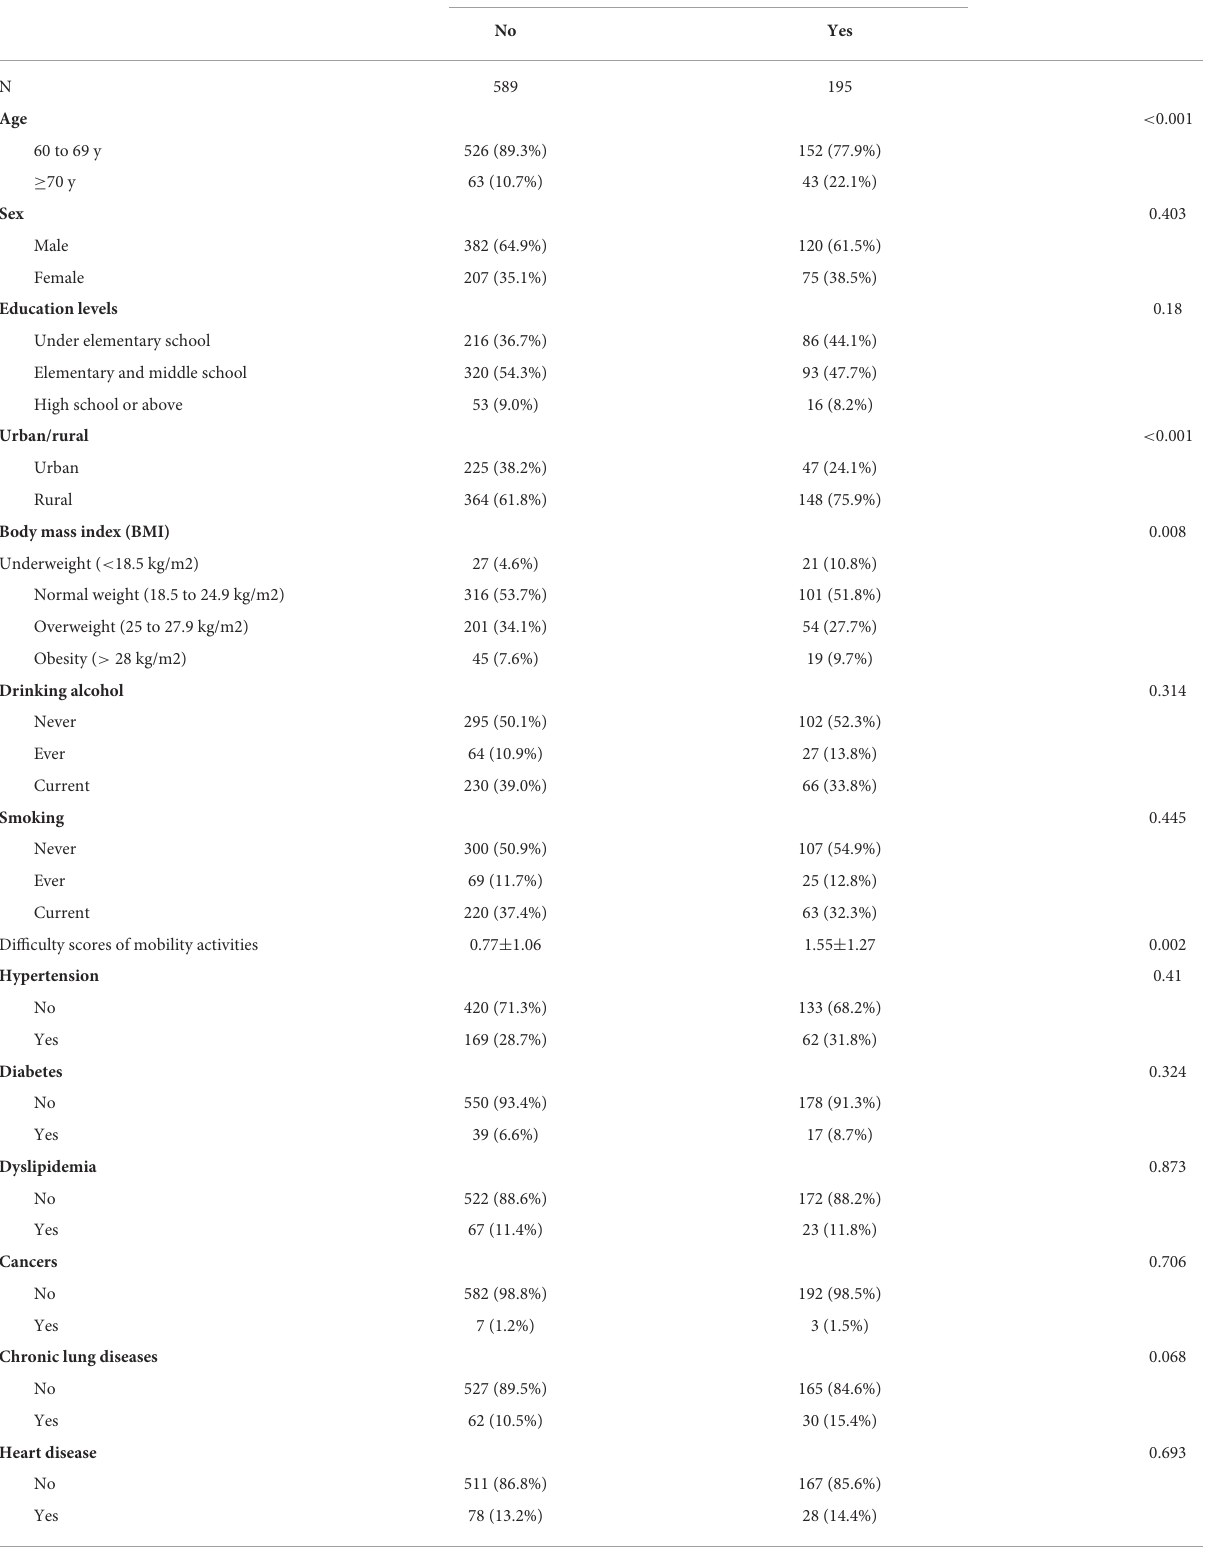
TABLE 1 Study population characteristics in the China health and retirement longitudinal study. Individuals with possible